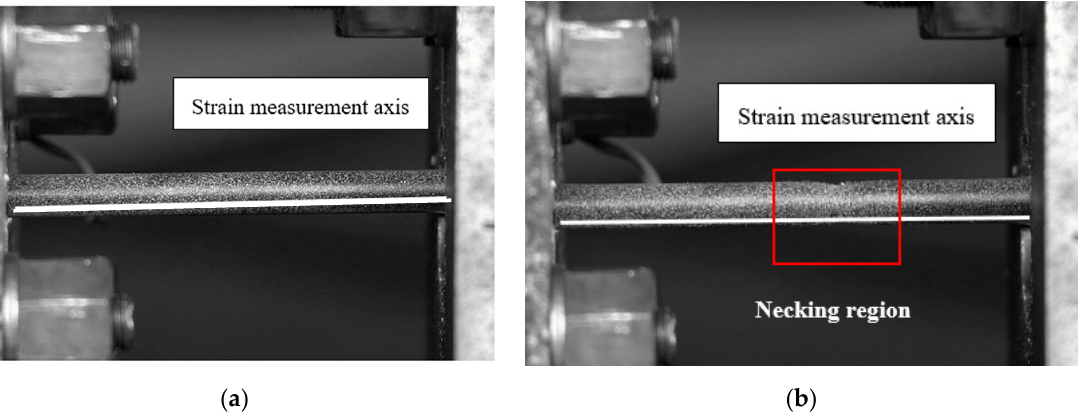
Figure 18. Stochastic speckle pattern used for DIC analysis during ( a ) beginning of the tensile test and ( b ) one frame before rupture.